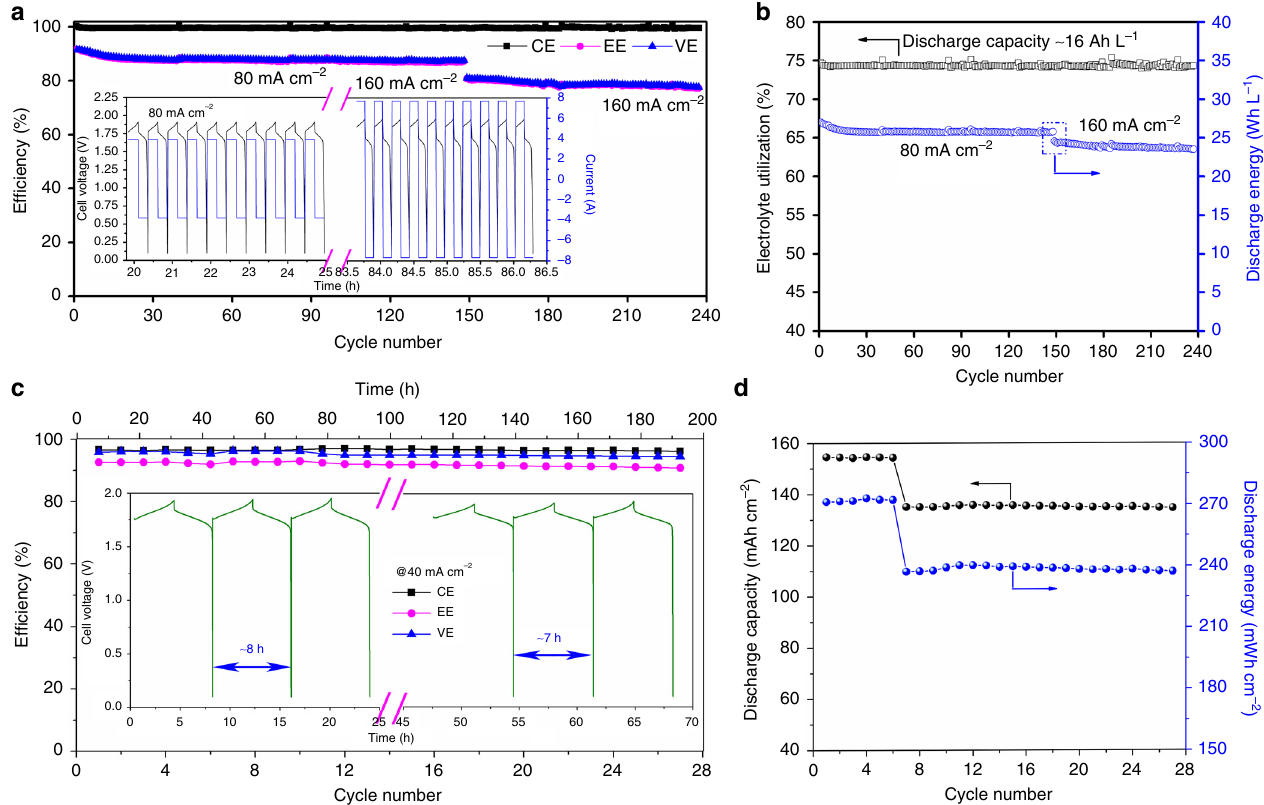
Fig. 6 Cycling performance of the alkaline zinc – iron fl ow battery. a Cycle performance of the alkaline zinc – iron fl ow battery using a P20 membrane. Insets: representative charge and discharge pro fi les. b Electrolyte utilization and discharge energy during the cycling. c Cycle performance of the alkaline zinc – iron fl ow battery at a current density of 40 mA cm − 2 . Inset: representative charge and discharge curves of the alkaline zinc – iron fl ow battery. The charge